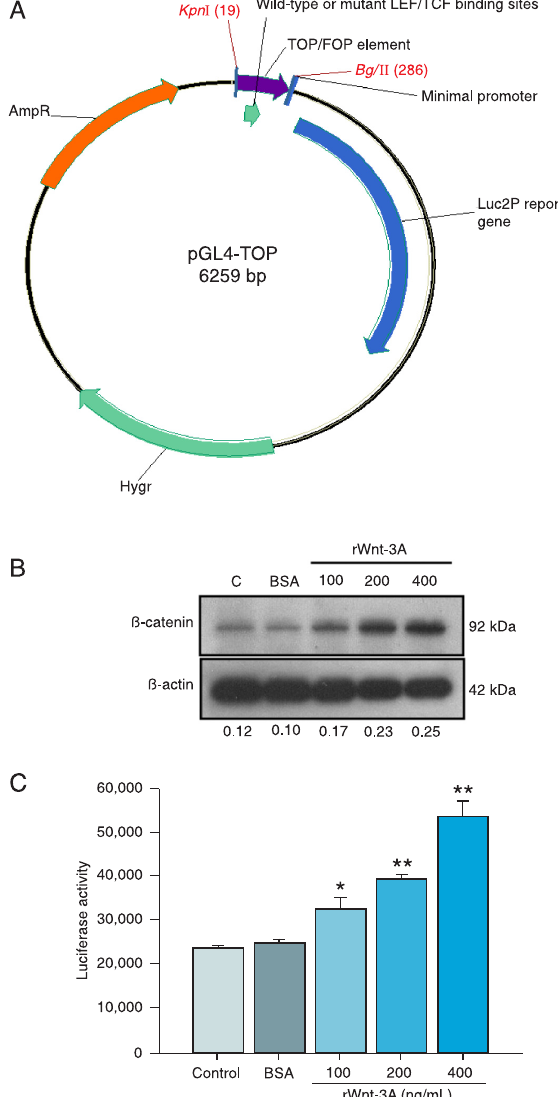
Figure 1. Map of the pGL4-TOP/FOP reporter plasmids and ef- fects of rWnt-3A on β-catenin protein levels and luciferase ac- tivities in HEK 293-TOP stable cells. A 265-bp fragment contain- ing the 3X LEF/TCF elements (19-286 bp) was amplified from TOPFLASH and FOPFLASH by PCR and inserted into the pGL4.3 reporter plasmid. The pGL4-TOP/FOP plasmid map was drawn with the Vector NTI software. LEF = lymphoid enhancer factor; TCF = T-cell factor protein; AmpR = beta-lactamase cod- ing region; Hygr = hygromycin B coding region. HEK 293-TOP cells (1 x 10 4 ) were seeded into a 96-well plate for 24 h and then treated with medium (C), BSA (0.1%) or the indicated concentra- tions of rWnt-3A (100, 200, 400 ng/mL) for another 24 h. Total cell proteins were collected and subjected to Western blotting (B) and the luciferase assay (C). The ratios of β-catenin to β-actin proteins are shown at the bottom of Panel B. Each bar in Panel C is the mean ± SD of three independent experiments. *P < 0.05, **P < 0.01 vs cells treated with 0.1% BSA (Student t